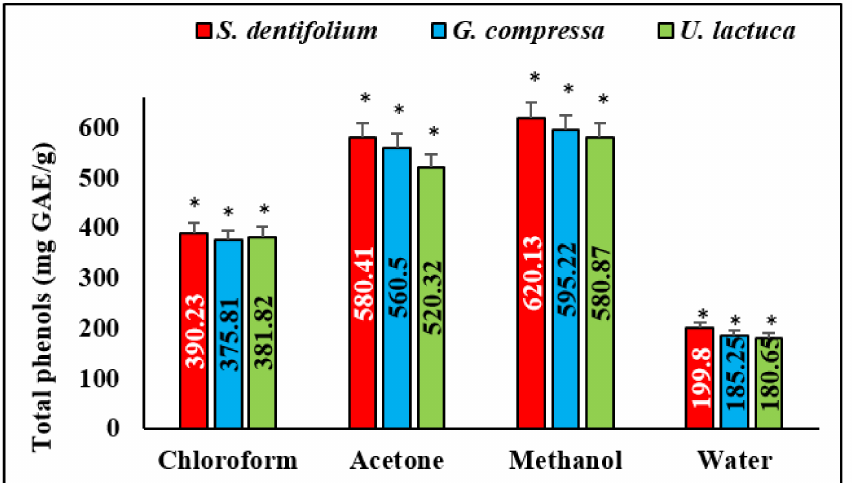
Figure 6. Total phenolic content of S. dentifolium , U. lactuca , and G. compressa extracts. The data are expressed as mg of gallic acid per gm dry extract (highly significant = * p < 0.05, n =